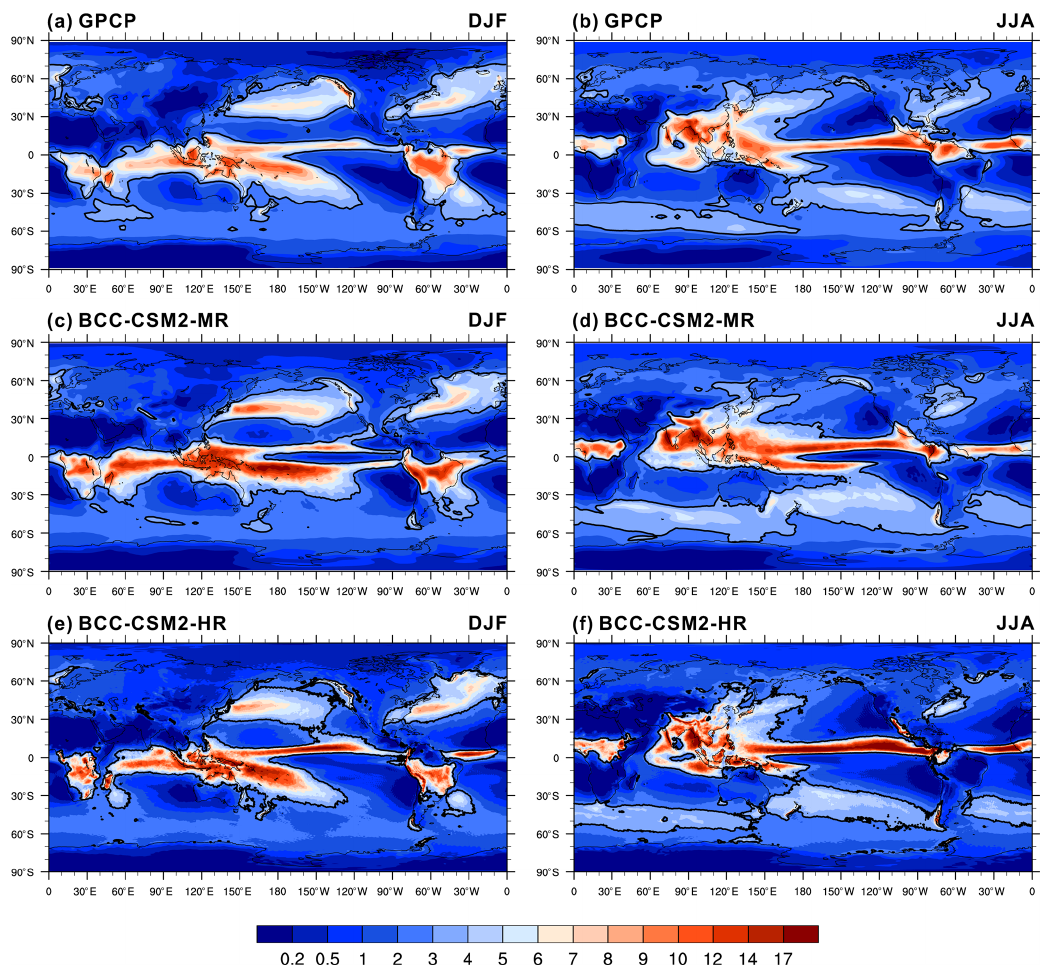
Figure 7. The 1995–2014 averaged mean precipitation rate of December–January–February (a, c, e) and June–July–August (b, d, f) for (a, b) GPCP observations, (c, d) BCC-CSM2-MR, and (e, f) BCC-CSM2-HR. Units: mmd − 1 . The 3mmd − 1 contour line is in bold as a reference to facilitate the visual